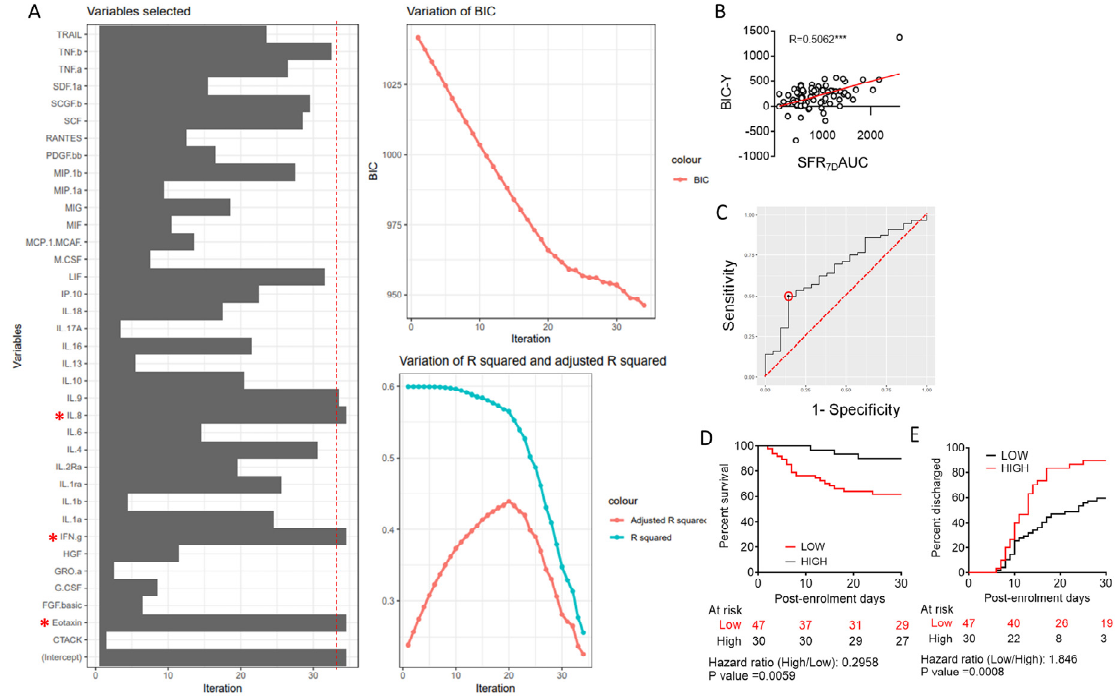
Figure 2. Machine learning to derive a minimal predictive model to describe blood oxygenation using plasma cytokine abundance in severe COVID-19 patients. ( A ) Bayesian information